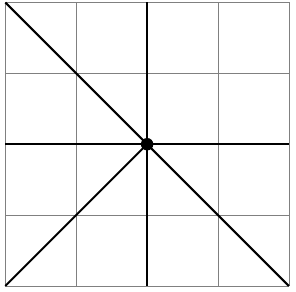
Figure 8 . The normal fan of the